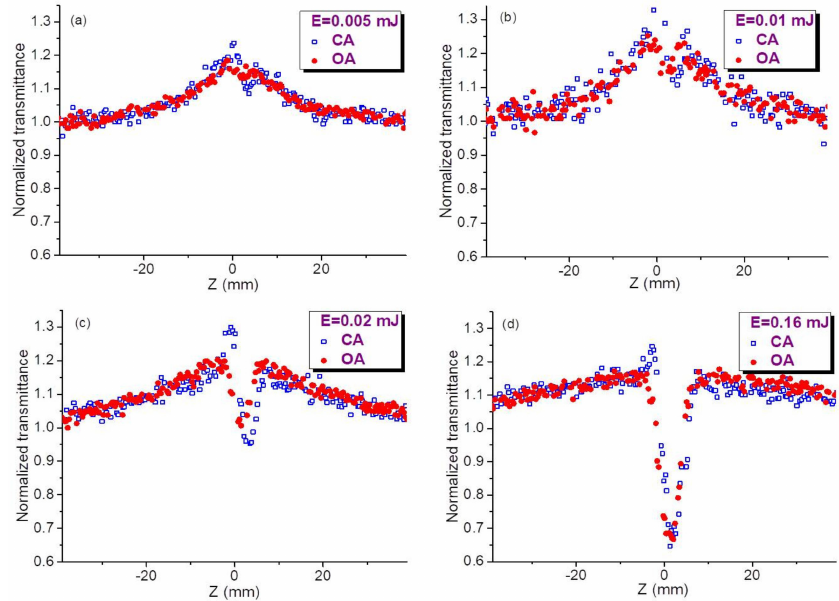
Figure 3. Open-aperture (OA, red filled circles) and closed-aperture (CA, blue empty squares) z-scans of InP@ZnS CQDs using 2.5 times larger concentration of QDs ( C = 5 × 10 − 6 M) compared with the case shown in Figure 2. These z-scans were measured at different energies of 532 nm